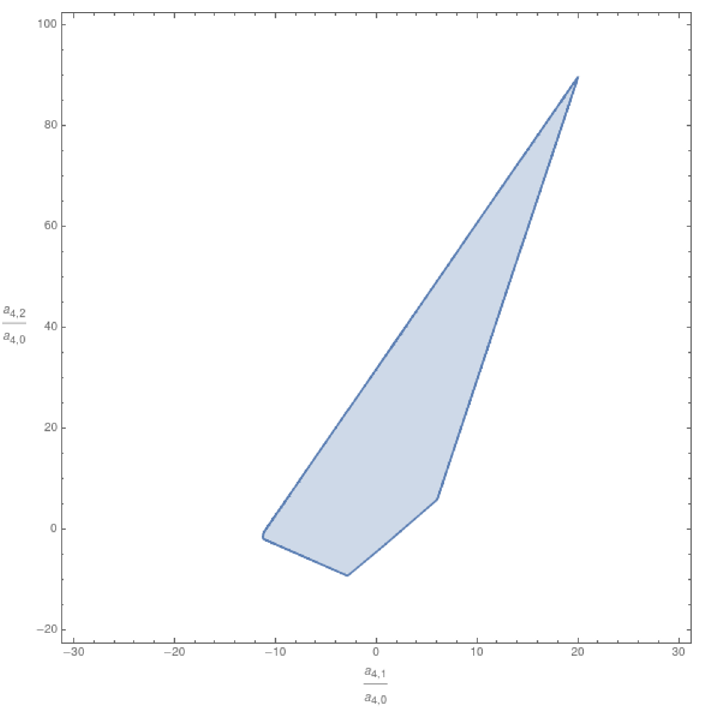
Figure 16 . The intersection of the P 4 polytope defined by the boundaries in eq. (9.13) with X sym